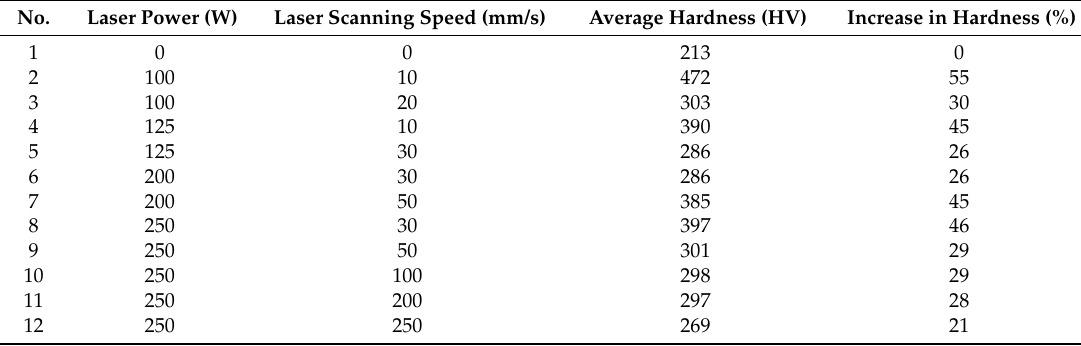
Table 2. Hardnesses obtained for different combinations of laser